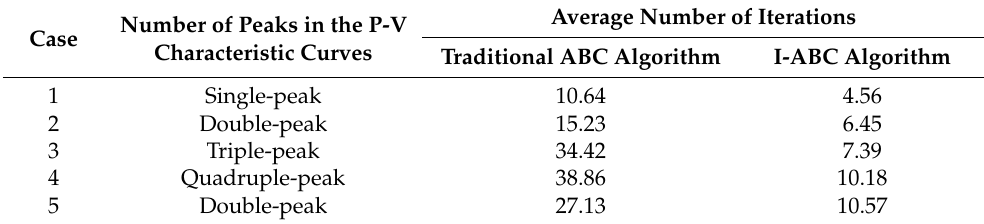
Figure 15. Comparison of simulation results for the MPPT in Case 5. Table 5. Comparison of the average number of iterations of the GMPPT based on two algorithms in 5